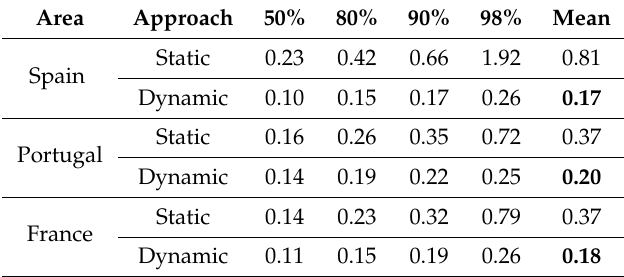
Table 6. Winkler score comparison on a monthly scale.